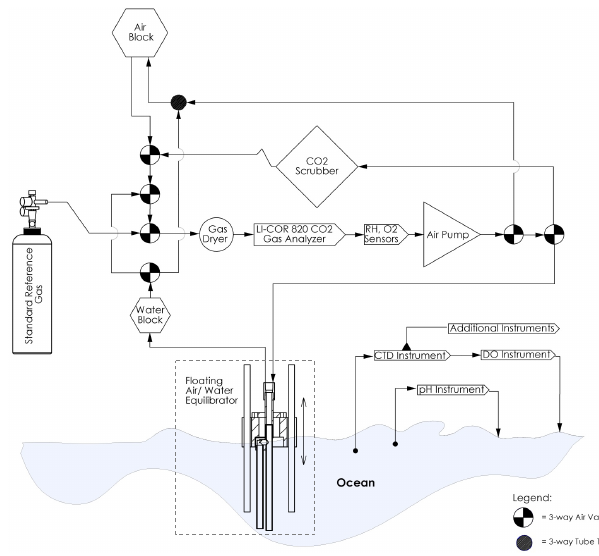
Figure 1. Schematic diagram of main components and sampling paths within the MAPCO 2 system. The floating air–water equili- brator is shown in more detail in Fig. 2.